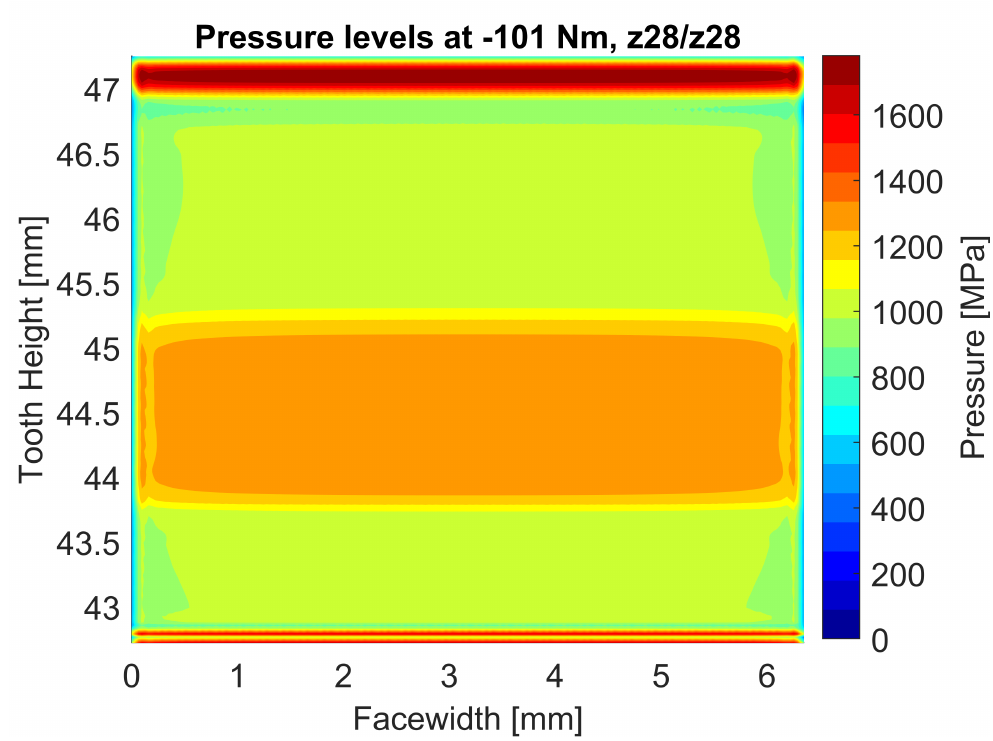
Figure 18. Flank pressure distribution of the tested gear pair with linear tip relief, dCa = 94.245 mm and Ca = 32 µ